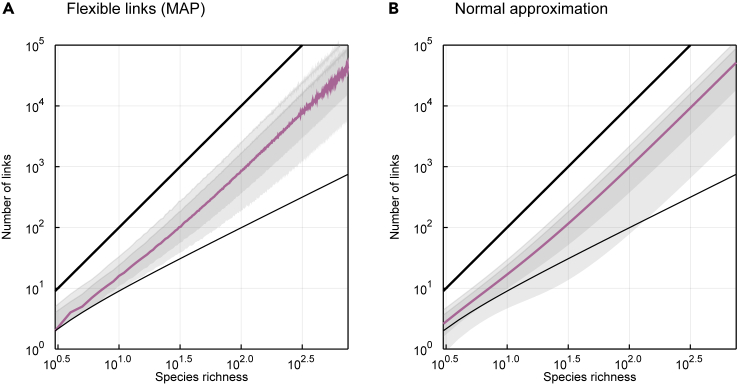
The Shifted Beta-Binomial Distribution Can Be Approximated by a Normal DistributionThe number of links is plotted as a function of species richness obtained from (A) the MAP estimates of the flexible links model and (B) its normal approximation. In each panel, the colored line represents the median predicted link number and the gray areas cover the 78% and 97% percentile intervals. The minimal S − 1 and maximal S2 numbers of links are plotted in each panel (thinner and bolder black lines, respectively).